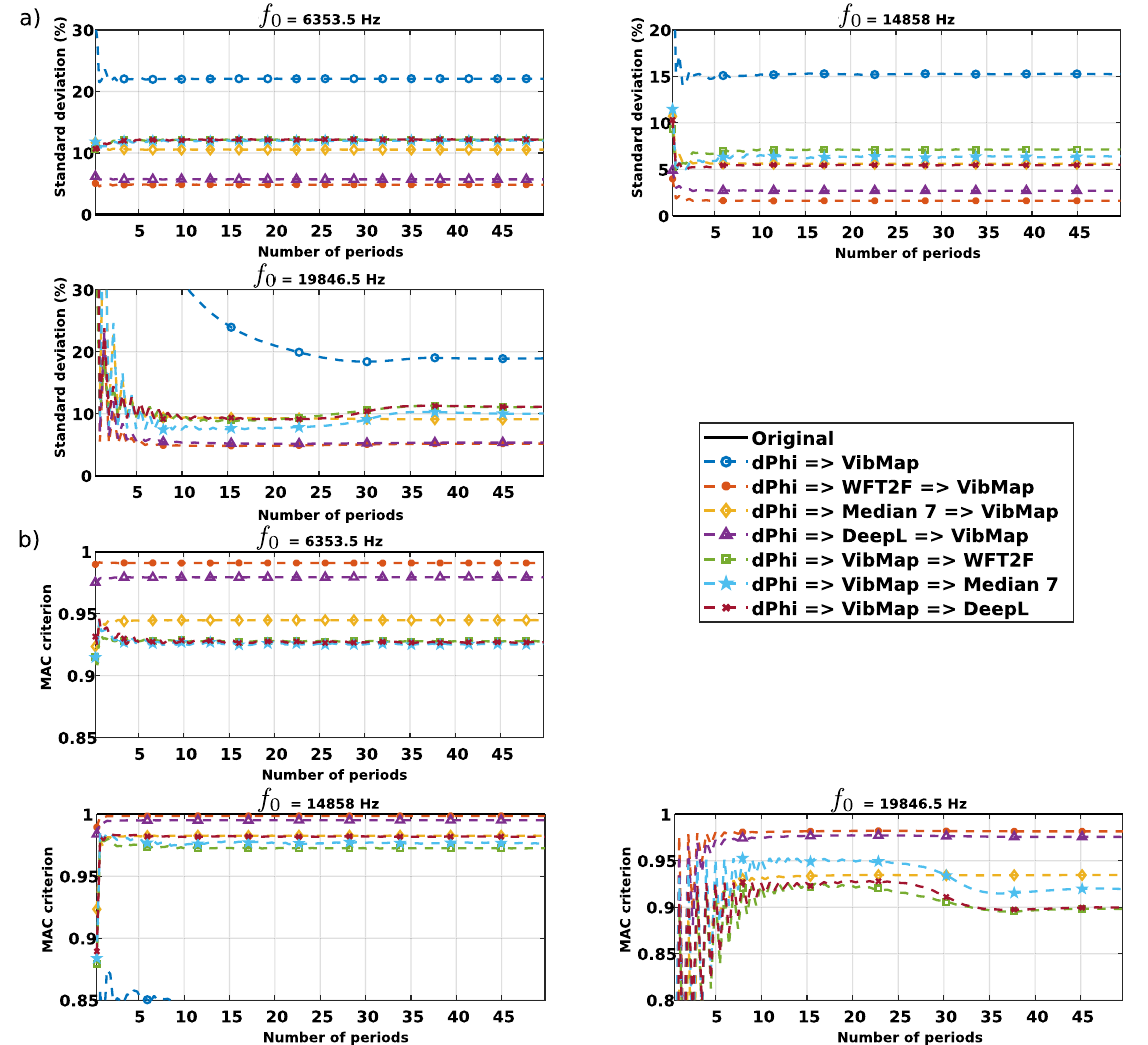
Figure 3. Comparison for each processing scheme applied to simulated data, (a) standard deviation for frequencies 6353.5 Hz, 14,858 Hz, 19,846.5 Hz, (b) MAC criterion for the same